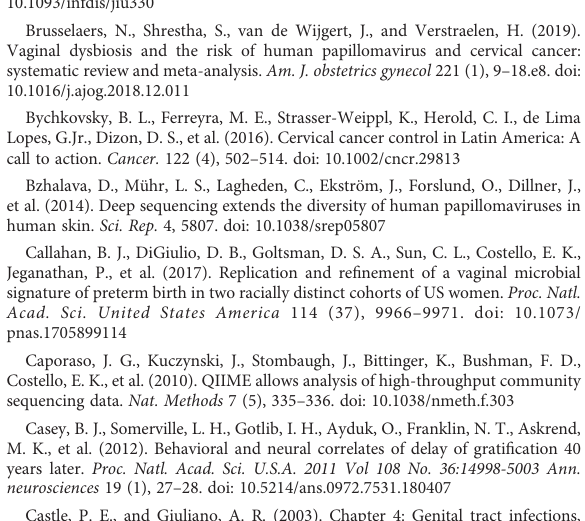
SUPPLEMENTARY FIGURE 1 Schematicdiagramoftheexperimentaldesignfromthesamplecollection to statistic